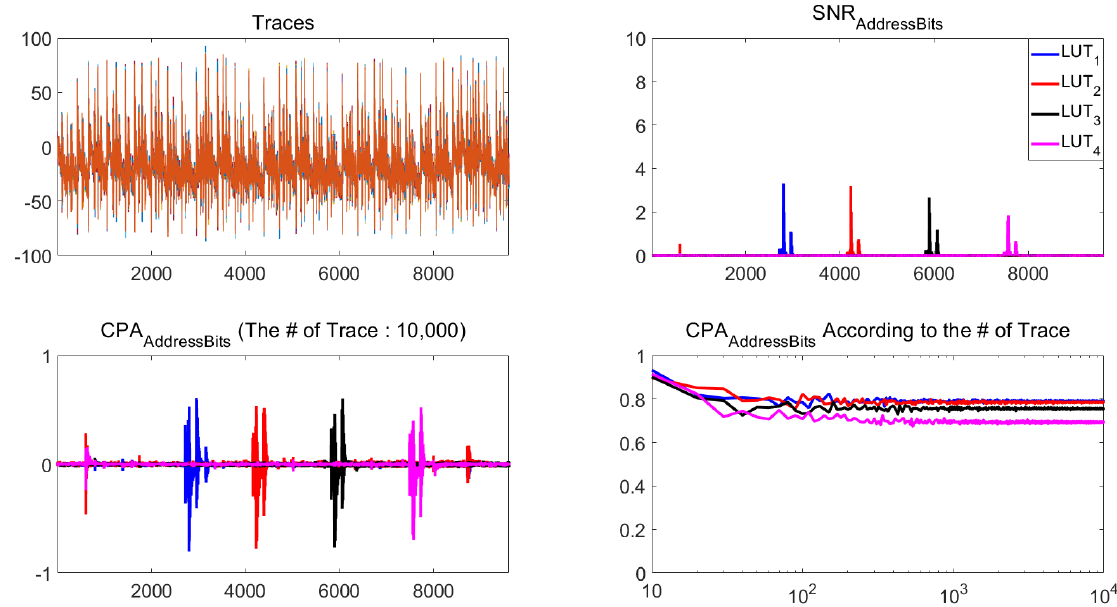
Figure 3. Evaluation results of Pour’s